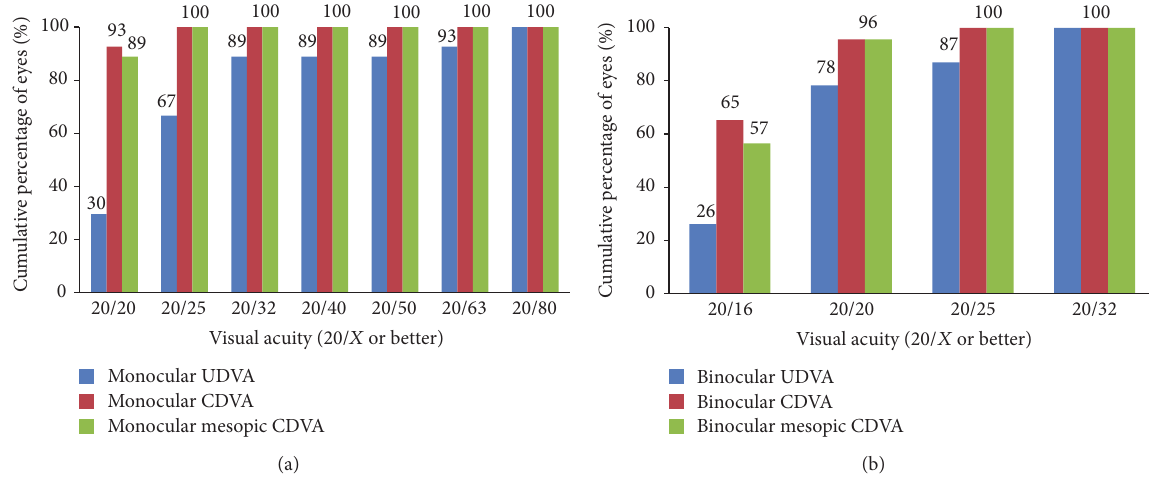
Figure 2: Monocular (operated eyes) and binocular uncorrected distance visual acuity (UDVA), corrected distance visual acuity (CDVA), and mesopic CDVA at the last visit.